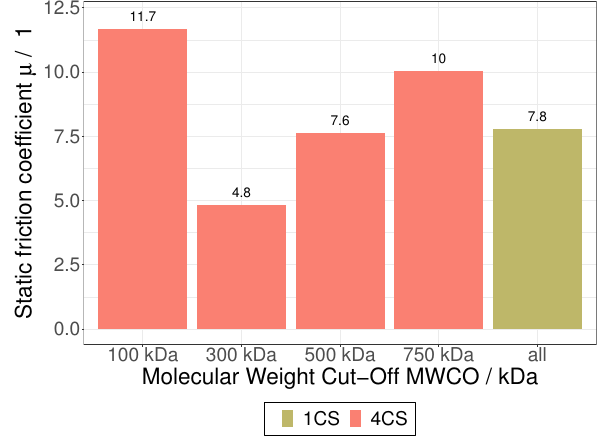
Figure 11. Comparison static friction coefficient µ of Schock for 4CS and 1CS. From a technical point of view, an optimization strategy can be drawn from the friction-based approach by using the apparent µ s for prediction purposes. Following this idea, permeate fluxes were predicted for different experimental conditions (different flow velocities and inner diameters of hollow fiber membrane) by maintaining shear rate values below 4500 s − 1 . The PFBM was fed with the calculated µ s in order to estimate the boundaries of the optimization potential for the HIV VLP TFF presented in this work.